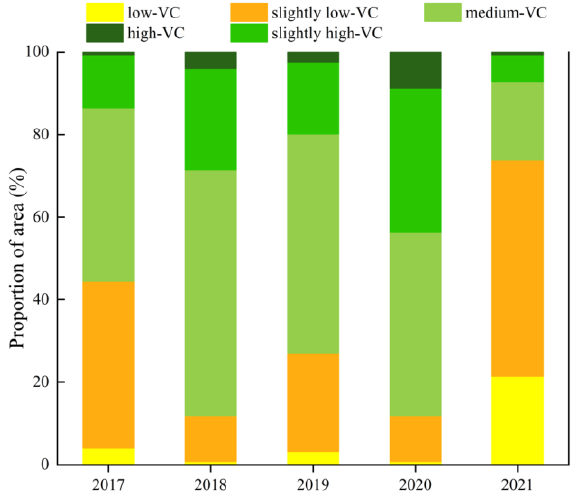
Figure 8. The area proportion of each NDVI grade during 2017 – 2021.